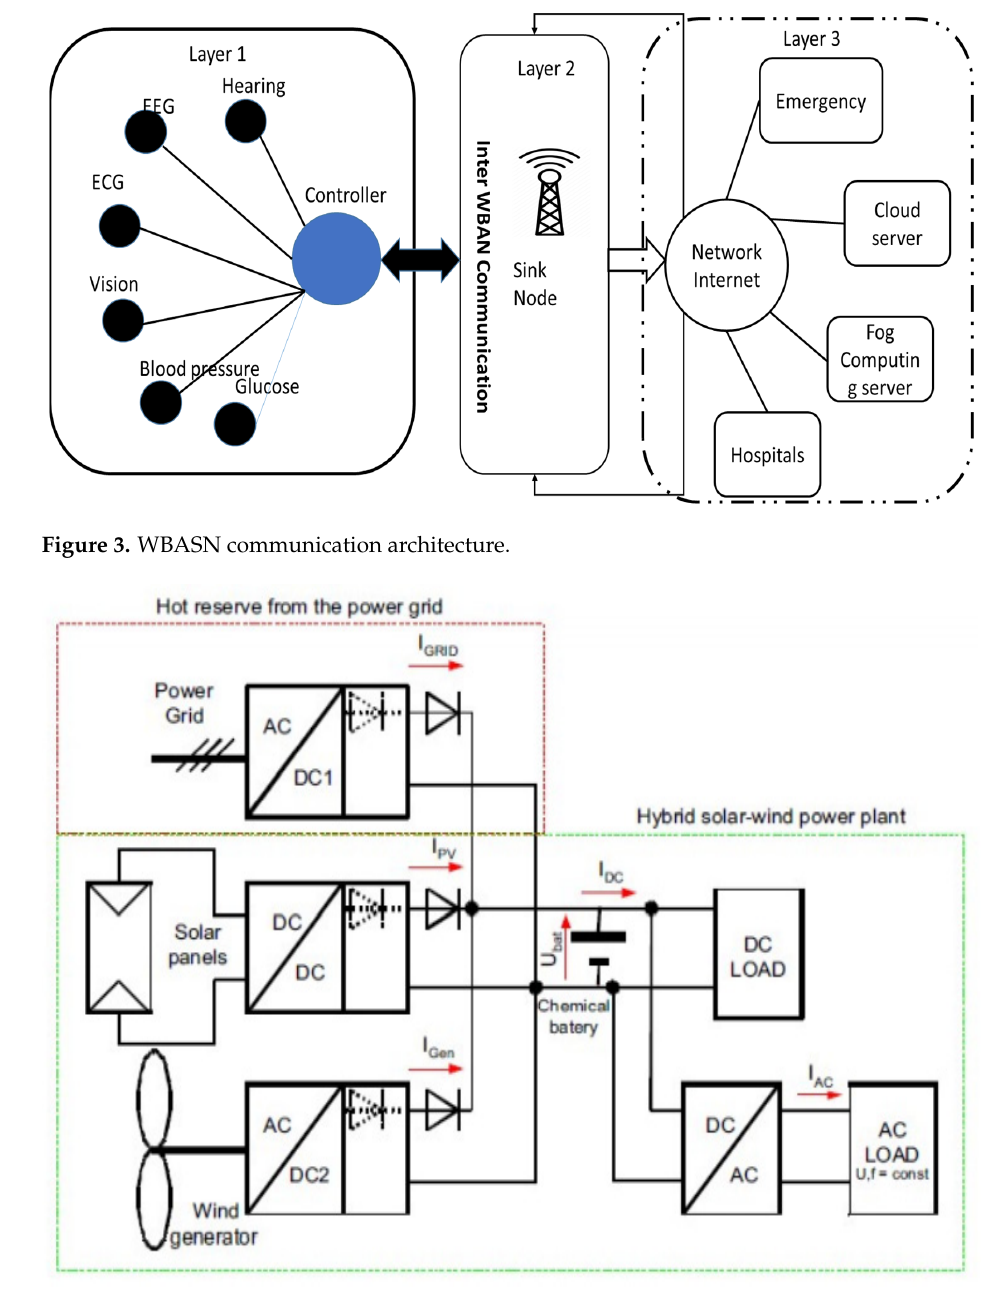
Figure 4. Block diagram of the hybrid solar–wind power plant.